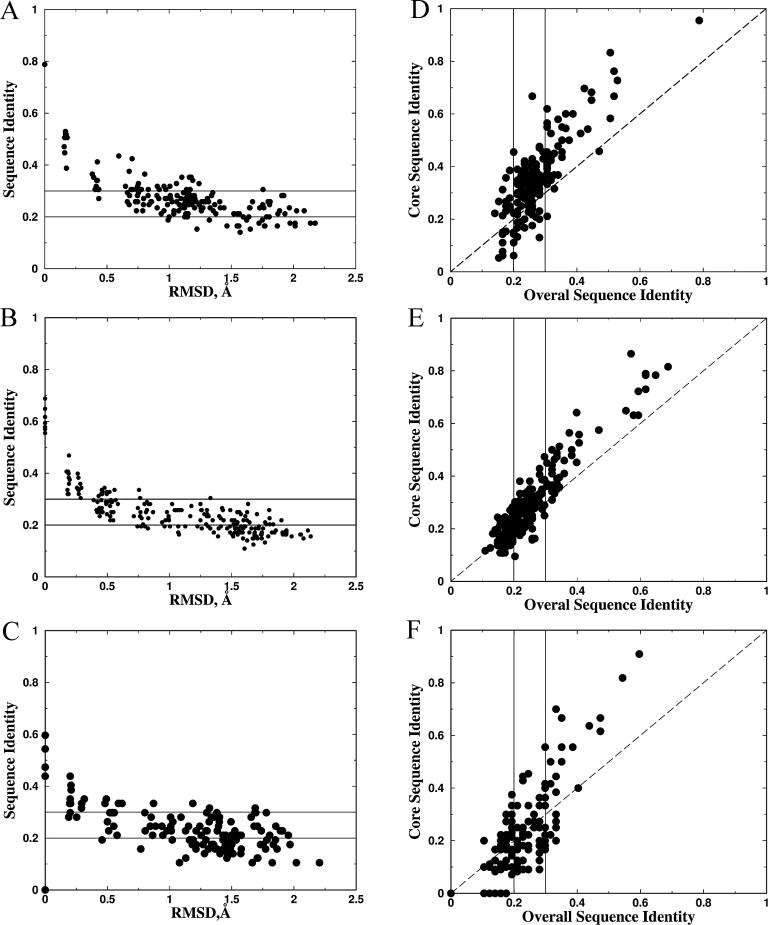
The Sequence Identity for the Constructed Homologous StructuresThree different protein folds are studied: HPR domain (A,B), ROSSMAN fold (D,E), and SH3 domain (G,H). (A,C,E) The sequence identities of the redesigned proteins using the flexible-backbone design simulation are presented as the function of the backbone-RMSD from the reference protein. (B,D,F) The sequence identity of the core is also plotted against the overall sequence identity. The “twilight zone” of sequence identity (20%–30%) corresponds to regions between horizontal (A,C,E) or vertical (B,D,F) lines.